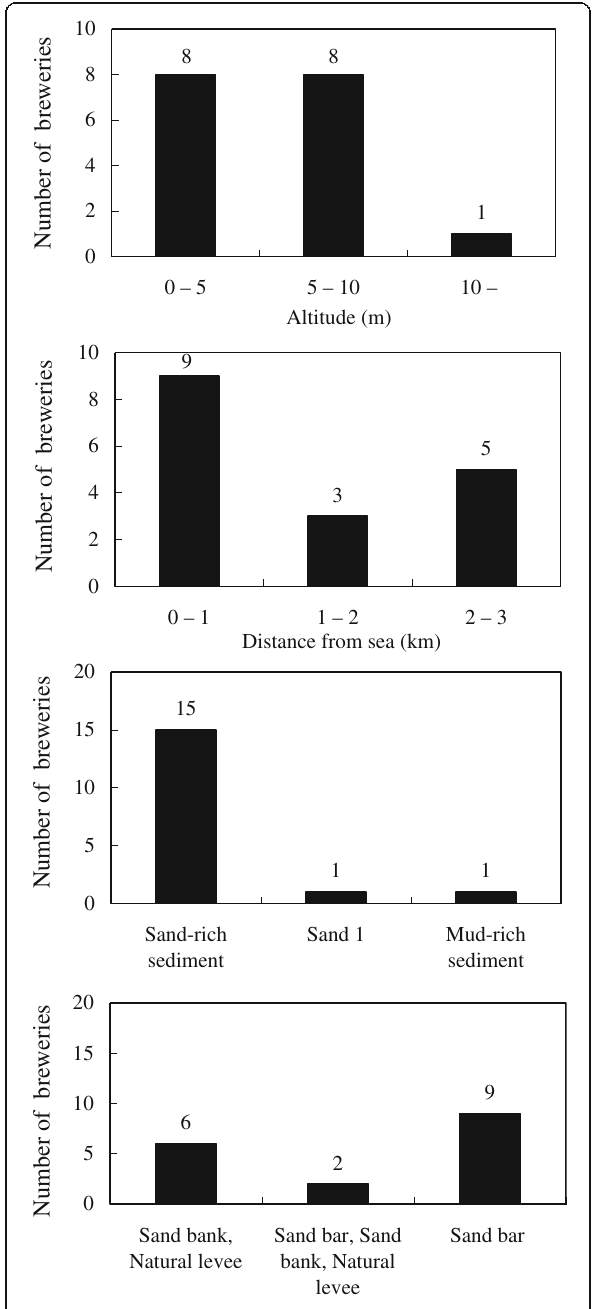
Fig. 9 Soil environment and distance from sea for area breweries operating in 1925